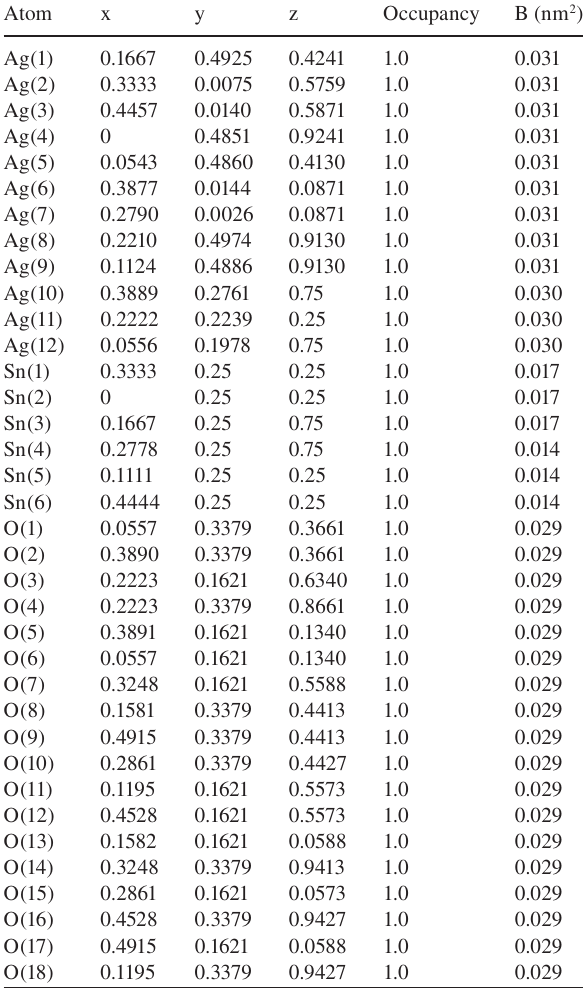
Table 2 Structural parameters for modulated structure of SnO . Ag 2 3